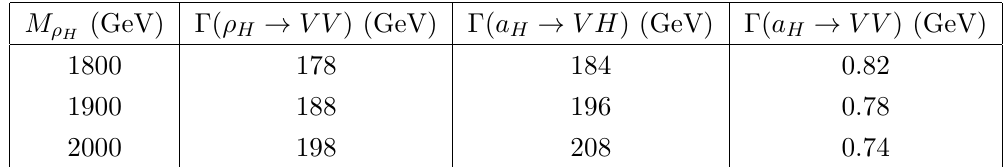
Table 2 . Principal decay rates of the isovector bosons (cid:26) H and a H for g (cid:26) 1 : 05 M (cid:26) ; from ref. [25]. These widths may be reduced by a factor of two or so by the (cid:22) tt and (cid:22) bt H content of H; W L ; Z L . Because the diboson decay modes are still dominant, this does not a(cid:11)ect their production rates.